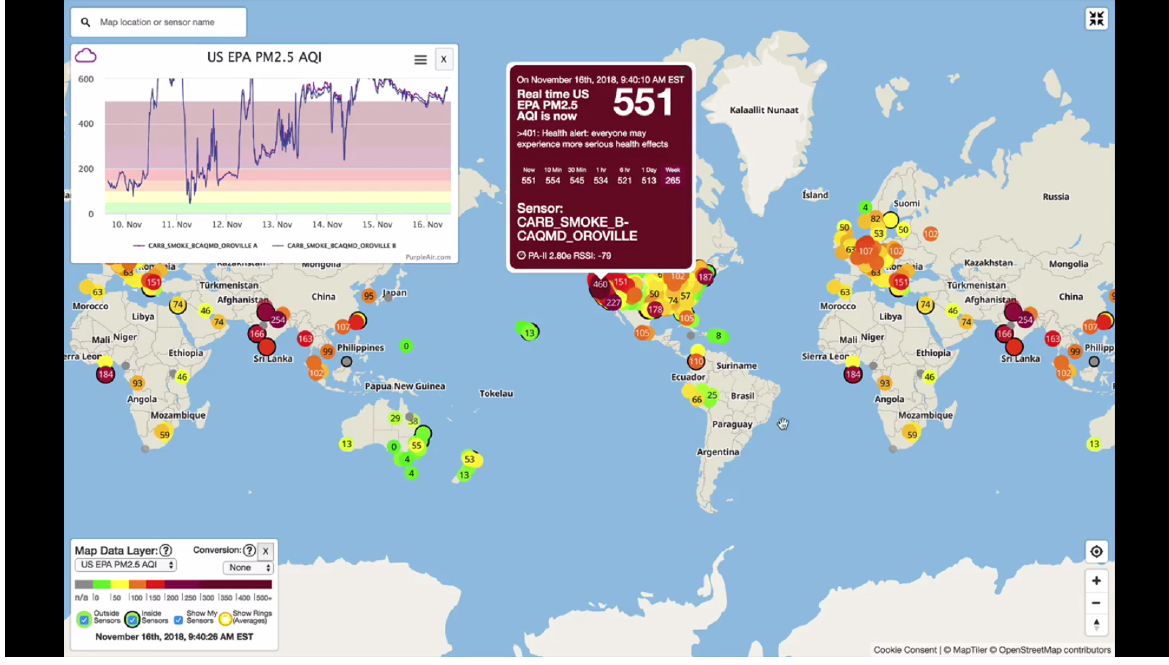
Figure 1: PurpleAir map animation, Inverse . Image courtesy of PurpleAir at www.purpleair.com. Available at https://www.inverse.com/article/50925-california-wildfire-air-quality-